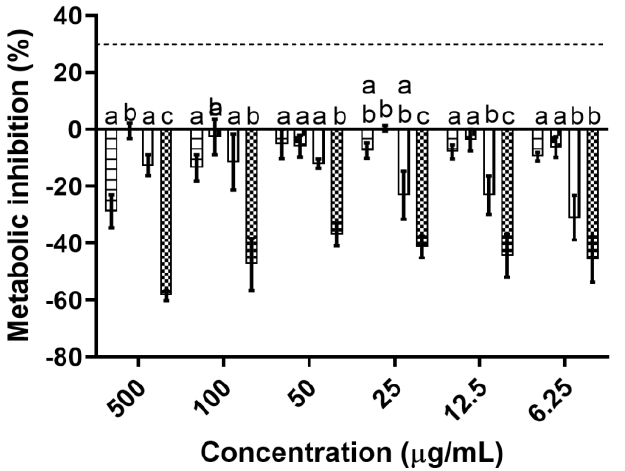
Figure 1. Peptide fractions antioxidant activity according to the ORAC assay. Different letters represent the statistically significant ( p < 0.05) differences found between the tested samples at the tested concentration.